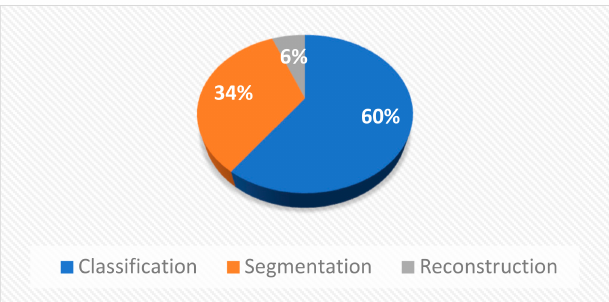
Figure 5. Types of problems that were studied.